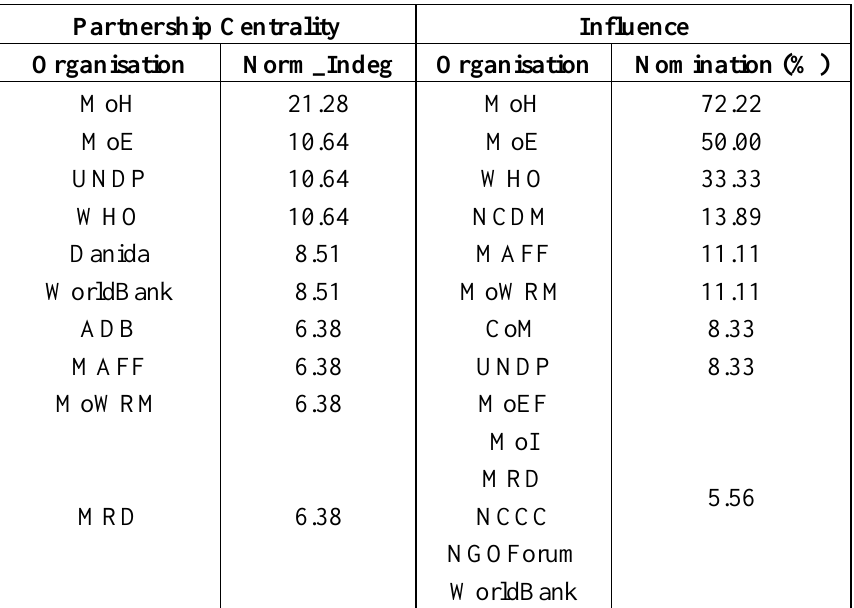
Table 8. Partnership centrality and influence: Top